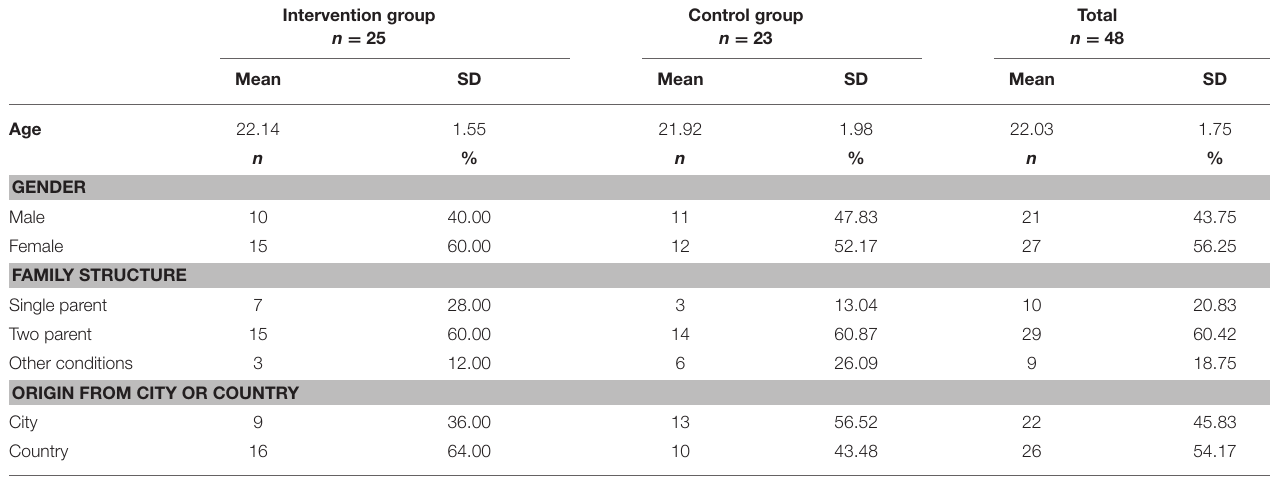
TABLE 1 | Comparisons between the groups regarding demographic data.